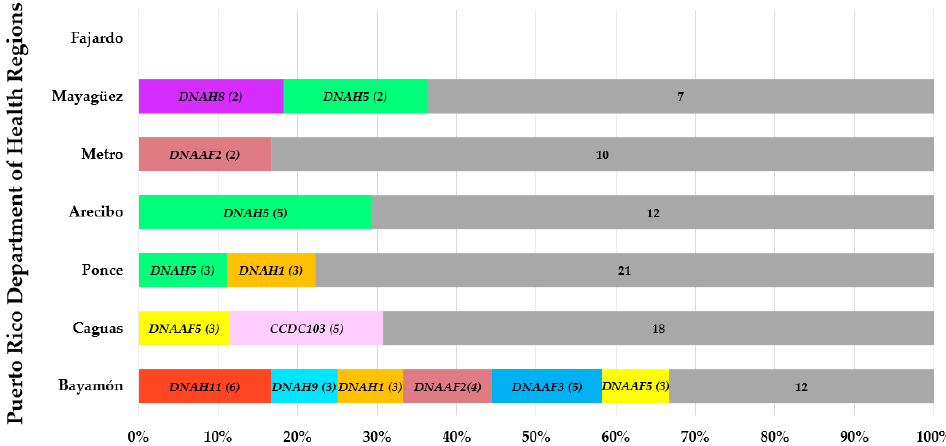
Figure 4. Percentage and numbers of total allele frequency of VUS in PCD genes in Puerto Rico. Gray bars show genetic variants with a frequency of less than 1.5% reported across regions.